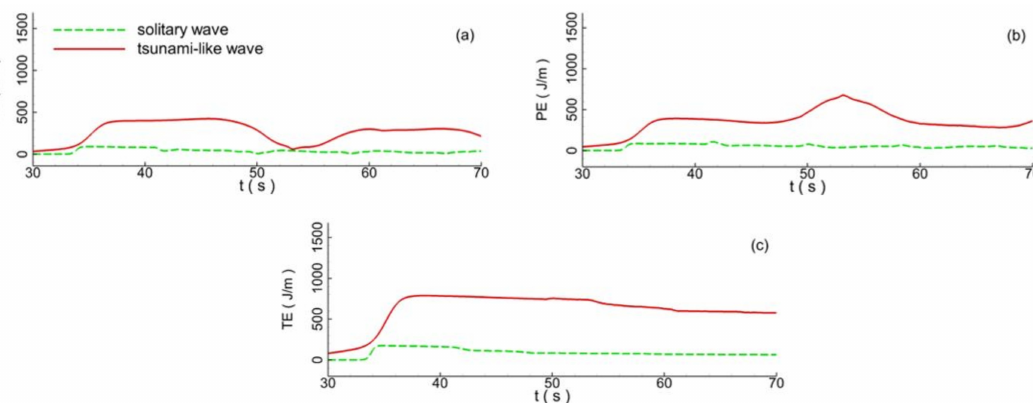
Figure 14. Comparison of the spatial distributions of maximum water surface elevation.